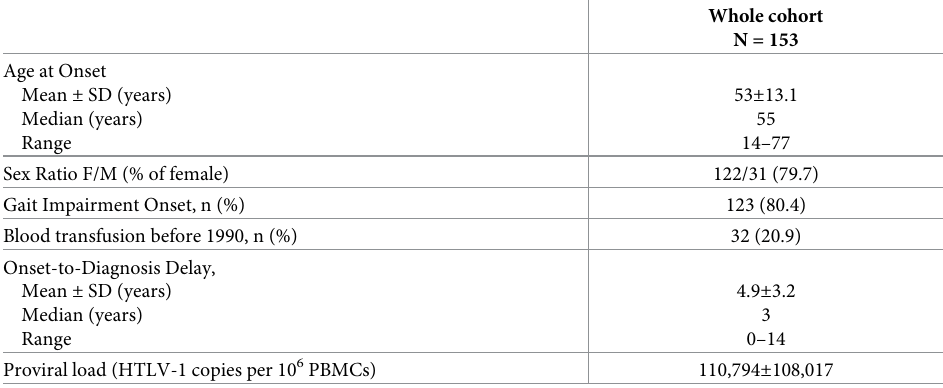
Table 1. HAM/TSP characteristics in the whole